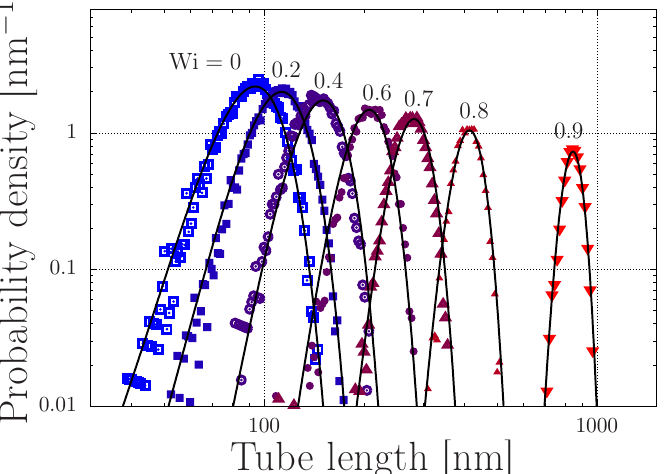
Figure 2. Stretch distributions of regular (non-sticky) polymers with Z e = 10 at various Weissenberg numbers Wi = ˙ ετ R with ˙ ε the extensional strain rate and τ R the Rouse time. The symbols are obtained by simulating Equation (5) in the absence of stickers ( Z s = 0) and without finite chain extensibility ( k s, i = 1). The solid curves are given by Equation (2), with λ = 1/ ( 1